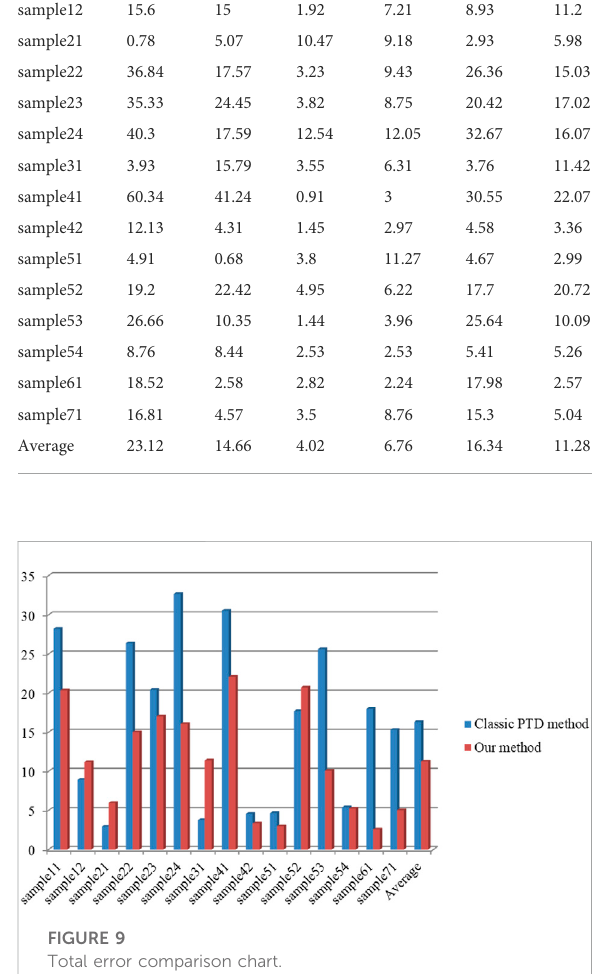
FIGURE 9 Total error comparison chart.